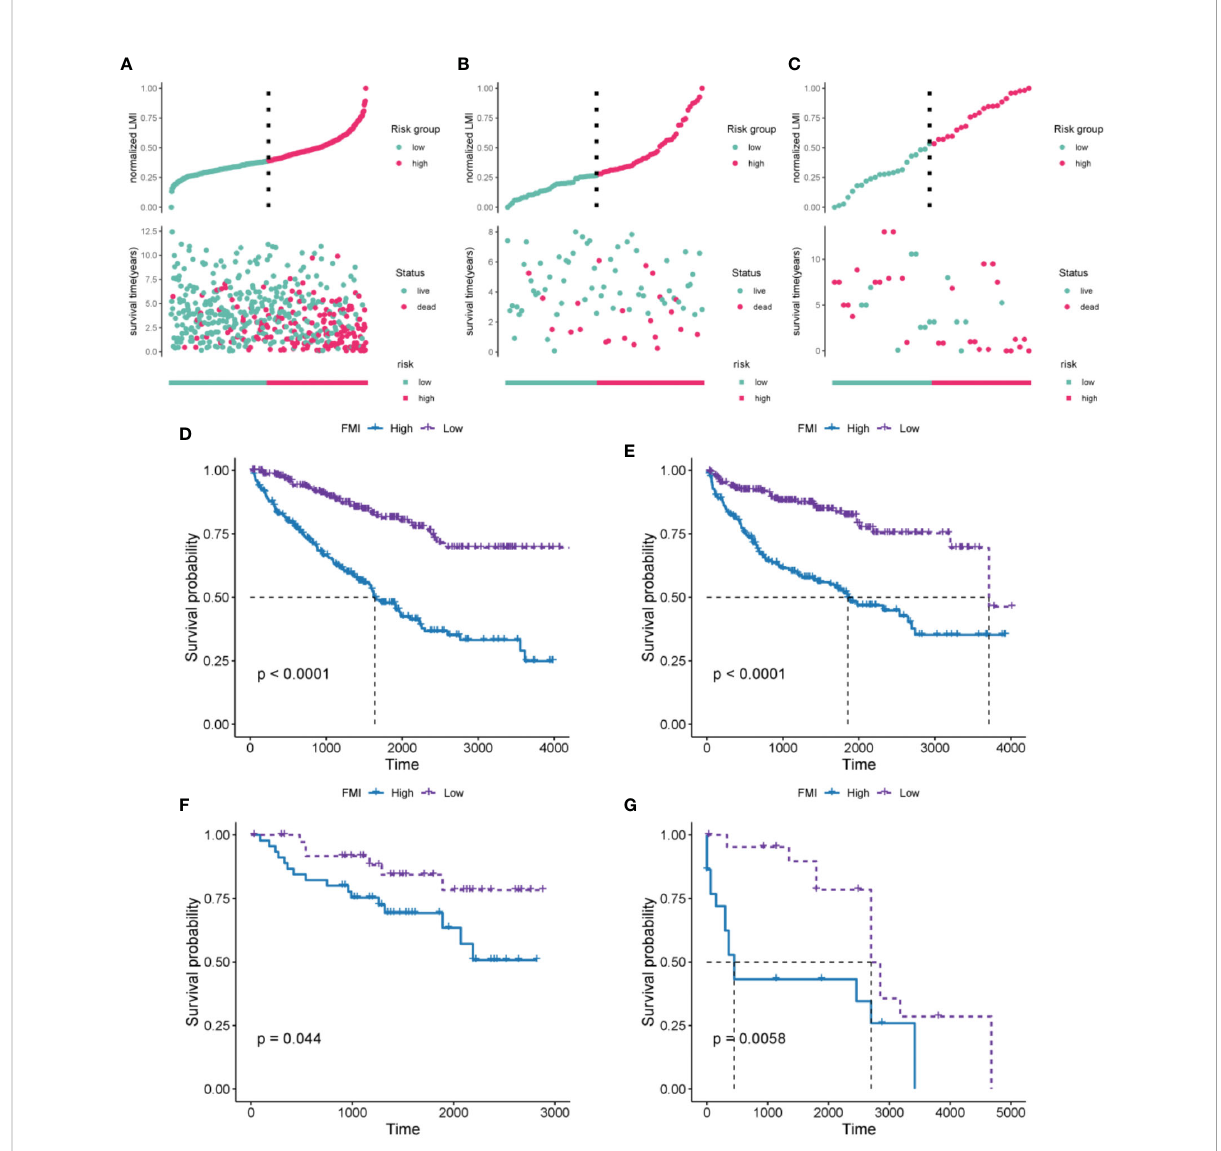
FIGURE 3 Evaluation and validation of the 10-FMG signature. Distribution plots of the patients ’ normalized FMI and OS status TCGA-KIRC (A) , E-MTAB- 1980 (B) , and GSE22541 cohorts (C) . K-M analyses of OS (D) and DFS (E) in the TCGA-KIRC cohorts. K-M analyses of OS (F) and DFS (G) in the E-MTAB-1980 and GSE22541 cohorts